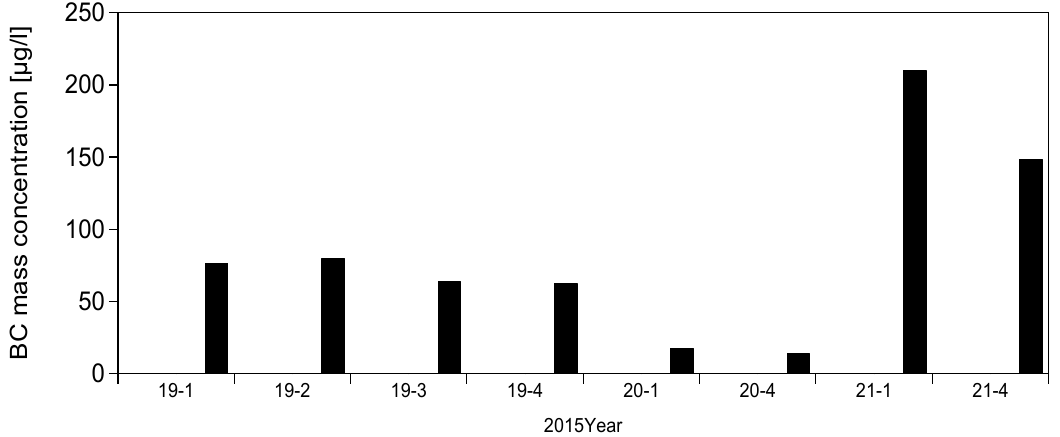
Figure 5. The mass concentration of BC in snow.